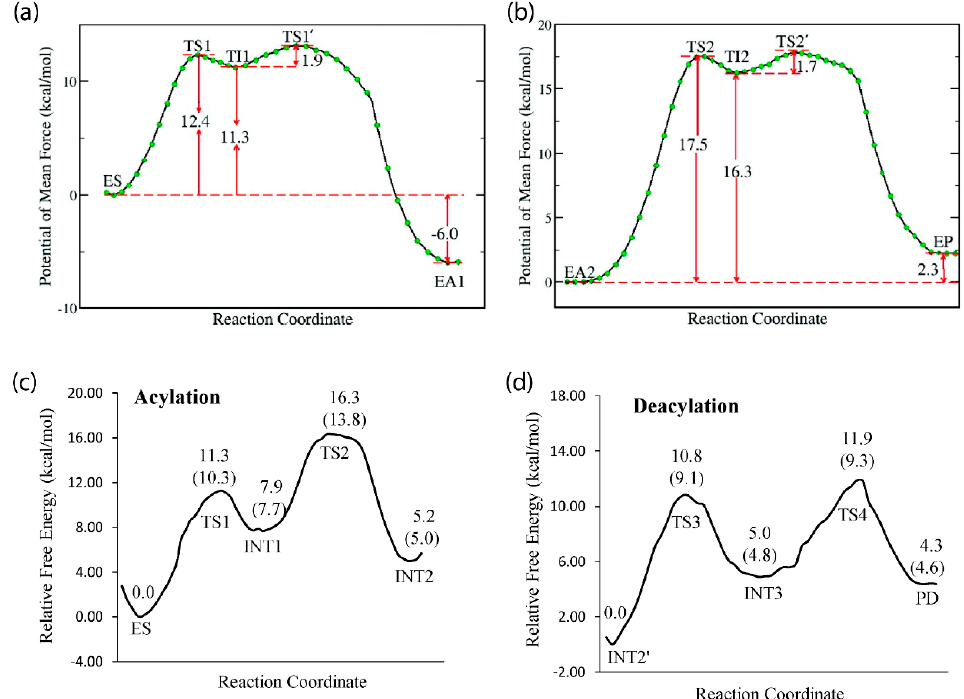
Figure 3. ( Top ) Free energy profiles for hydrolysis of ACh by AChE including the ( a ) acylation and ( b ) deacylation steps [71]. ( Bottom ) Free energy profiles for hydrolysis of ACh by BChE showing analogous ( c ) acylation and ( d ) deacylation steps [72].